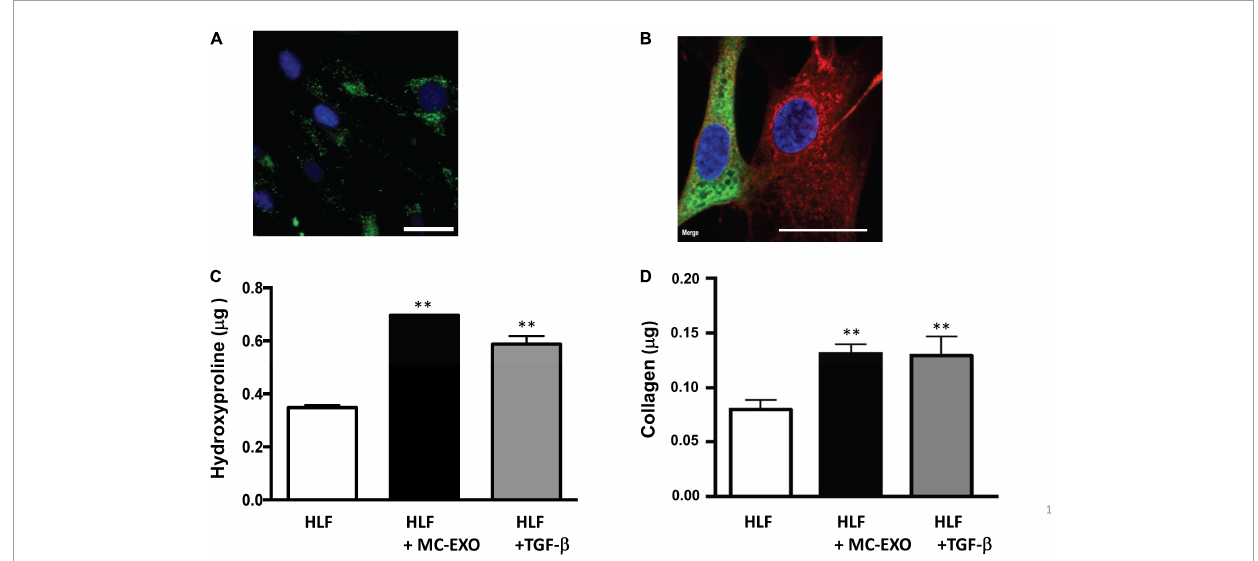
FIGURE1 MC-EXO are taken up by HLFs and stimulate collagen synthesis. (A) Representative epifluorescence image of HLF uptake of MC-EXO labeled with PKH-67 (green). Nuclei are labeled with 4 (cid:48) ,6-diamidino-2-phenylindole (DAPI) (blue). Scale bar = 15 µ m. (B) Representative confocal image of HLF uptake of MC-EXO labeled with CellVue Claret Far Red (red). HLFs were transiently transfected with mNeonGreen-KDEL, a fluorescent marker of the endoplasmic reticulum. Nuclei are labeled with DAPI (blue). Note that only the HLF on the left was successfully transfected with the mNeonGreen-KDEL marker. Scale bar = 15 µ m. (C) Hydroxyproline content of lysates from HLF, HLF incubated with MC-EXO (40 µ g total protein) or TGF- β (10 ng/ml) at the 72 h time point. All assays performed in triplicate and normalized to total protein ( µ g). ∗∗ P < 0.01 versus HLF, n = 5 samples/group. (D) Secreted collagen in supernatants of HLF, HLF incubated with MC-EXO (40 µ g total protein) or TGF- β (10 ng/ml) for 72 h. All assays were performed in triplicate and normalized to total protein ( µ g). ∗∗ P < 0.01 versus HLF, n = 5 samples/group.